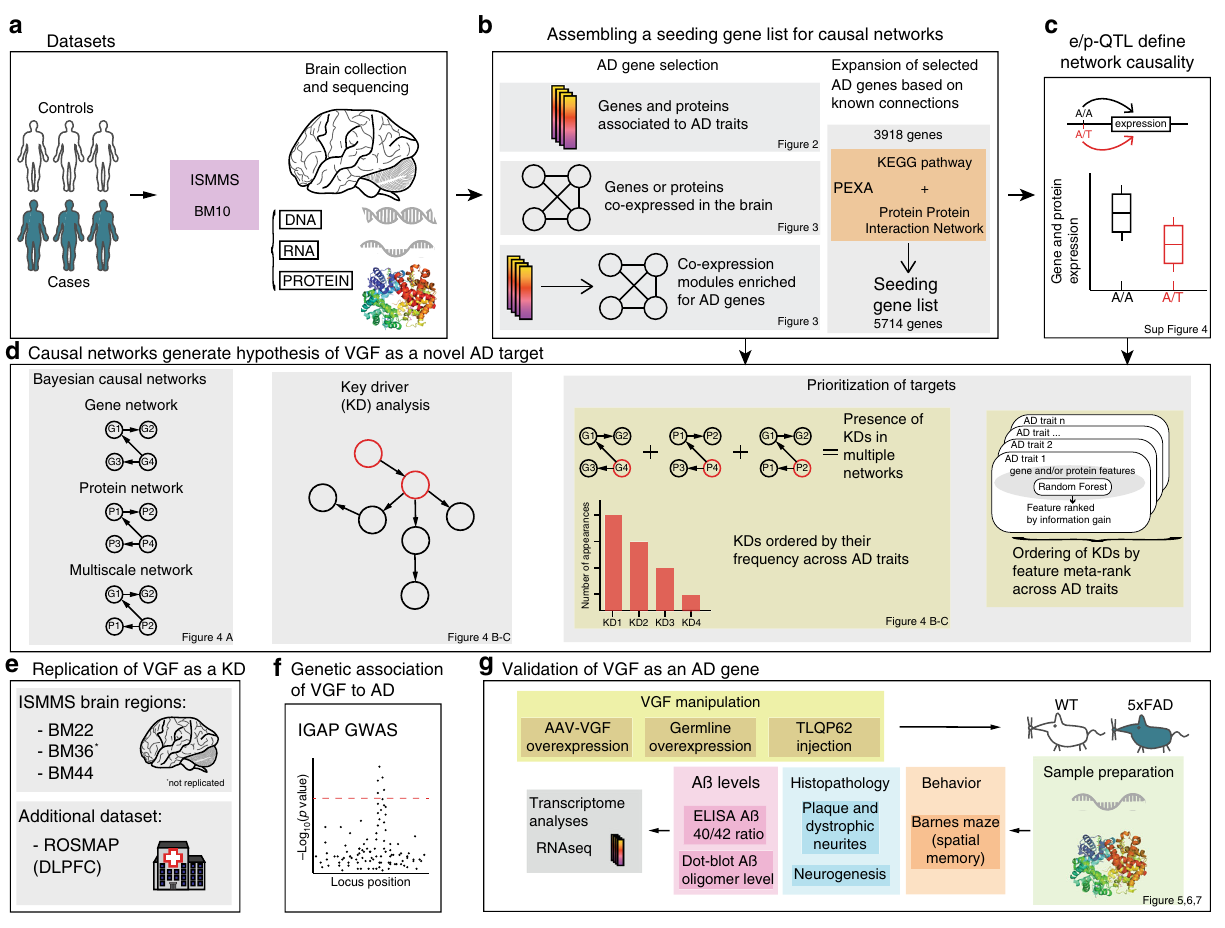
Fig. 1 Pipeline overview. Large-scale, high-dimensional datasets generated in hundreds of subjects serve as the input into our integrative pipeline ( a ), which comprises a series of steps that fi rst generate the appropriate input features for causal network reconstructions ( b , c ), then network reconstruction and identi fi cation of key driver genes ( d ), and fi nally validation via three independent paths: replication ( e ), human genetic association ( f ), and experimental disease model ( g